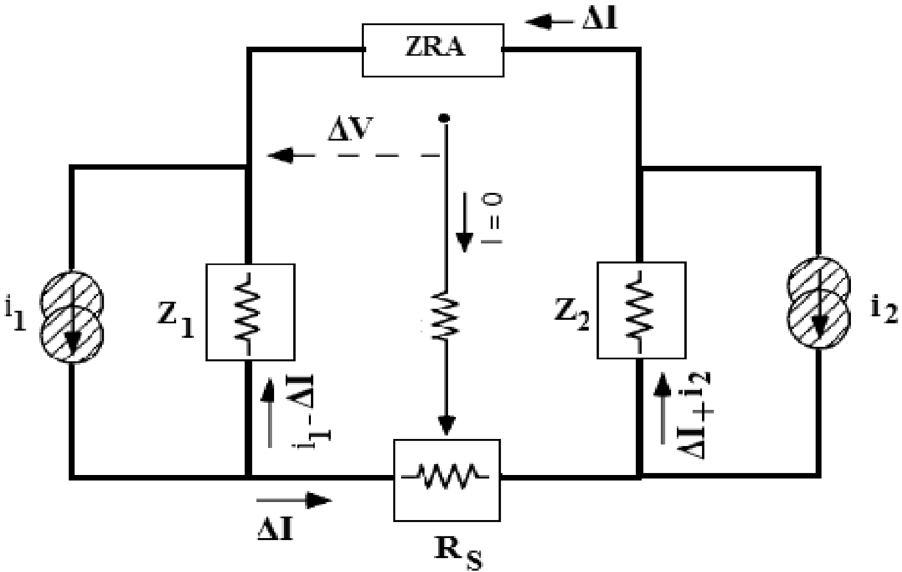
Figure 1. The equivalent circuit of corrosion cell to measure